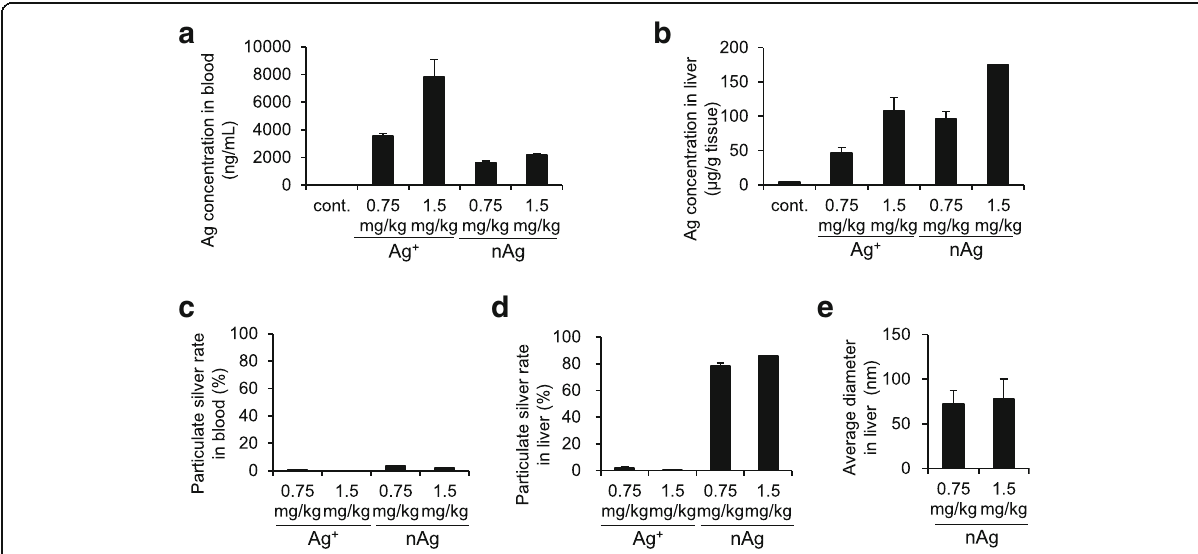
Fig. 4 Simultaneous quantification and physical property analyses of intravenously administered nAg100 and Ag + . nAg100 and Ag + were intravenously administrated in mice (0.75 or 1.5 mg/kg). After 24 h, their livers and blood were collected. All samples were pretreated with NaOH solution. Ag concentration in a blood and b liver were measured by ICP-MS. nAg in c blood and d liver were measured by sp-ICP-MS. The average diameter of the particles detected in the liver is shown in e . The results are expressed as mean ± SE ( n =